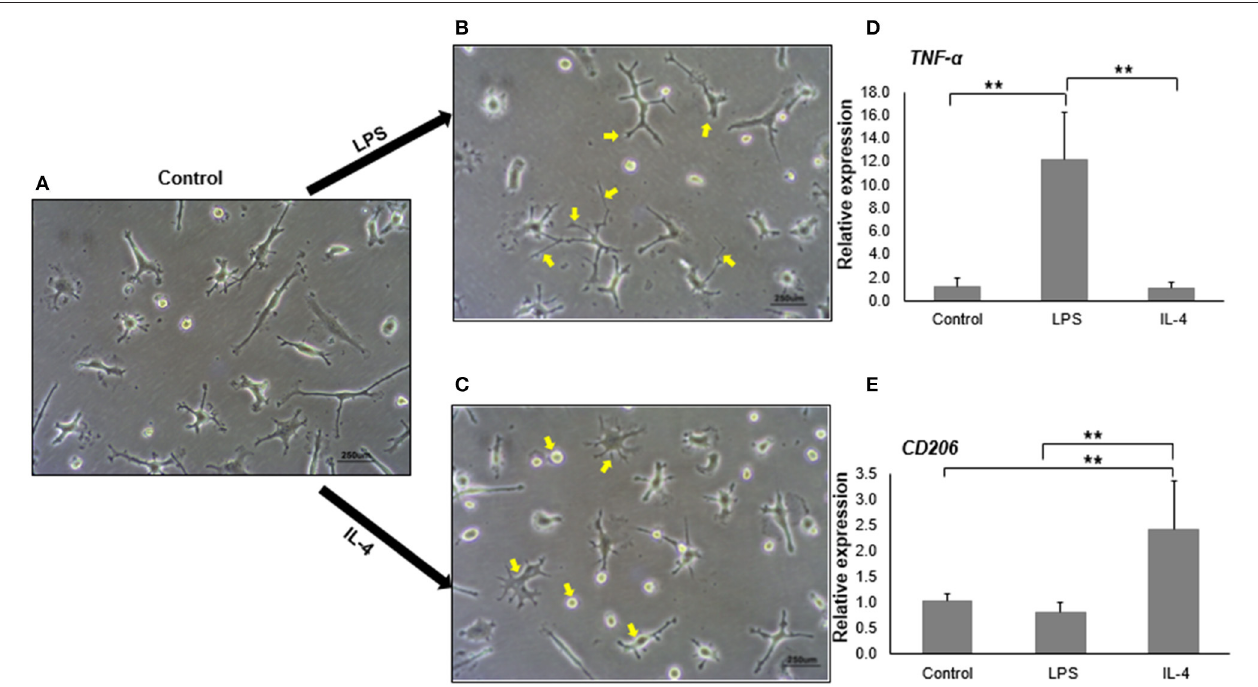
FIGURE 4 | In vitro activation and polarization of iMG cells. The morphology of iMG cells was captured after stimulation with LPS or IL-4 for 24h. (A) Control iMG cells without any treatment, (B) iMG cells stimulated with 10 µ g/ml LPS showing hyper-ramification as indicated with arrows, (C) iMG cells stimulated with 20ng/ml IL-4 showing ameboid structure as indicated with arrows. Changes in gene expression were analyzed by qRT-PCR showed (D) increased TNF- α levels in LPS-stimulated iMG cells and (E) increased CD206 levels in IL-4-stimulated iMG cells. The experiments were all repeated at least three times. Data were represented as a mean ± SD. Significance between groups were determined by ANOVA test, where ** denoted p <